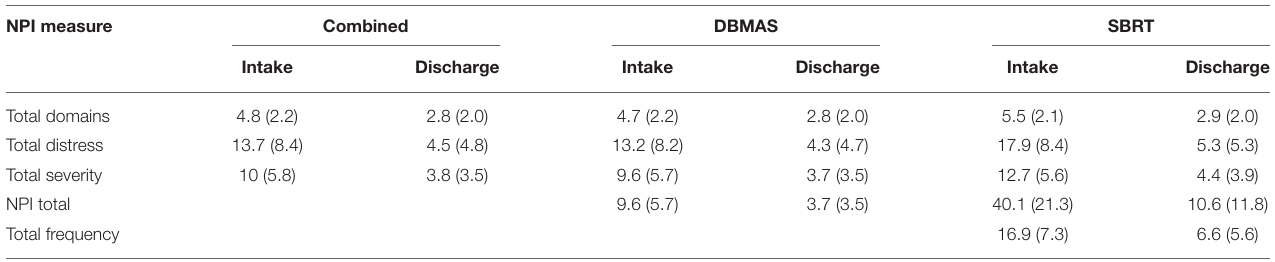
TABLE 4 | Clinical impact of DSA programs on NPI